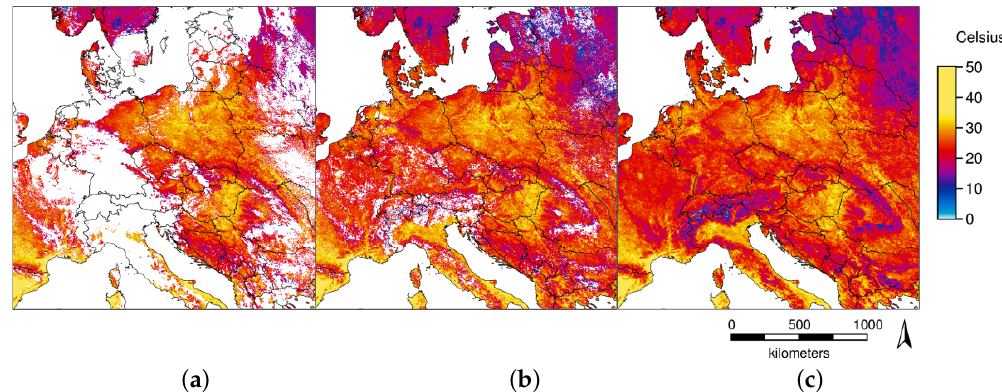
Figure 4. Reconstruction of missing values for 8 June 2016: ( a ) original LST data; ( b ) after temporal interpolation; and ( c ) after spatial interpolation.